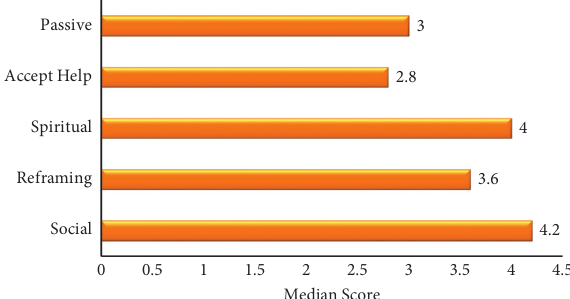
Figure 2: Extent of caregivers’ usage of the F-COPES subscale support